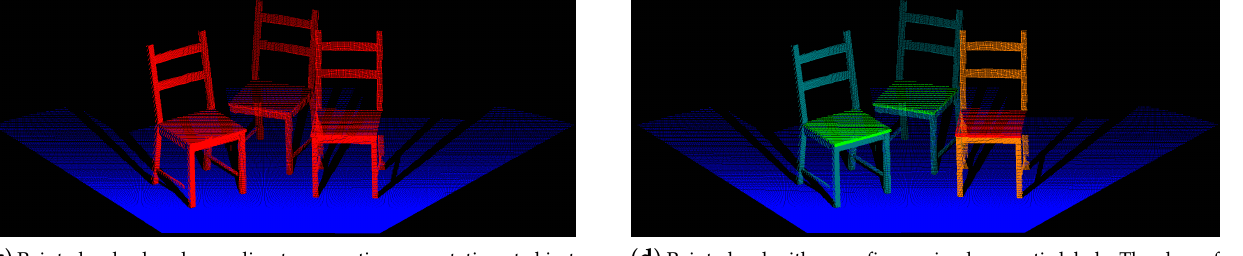
Figure 11. A simple scene in Blender ( a ) and three visualizations of a point-cloud generated by a virtual depth sensor. The bottom row shows two alternative semantic